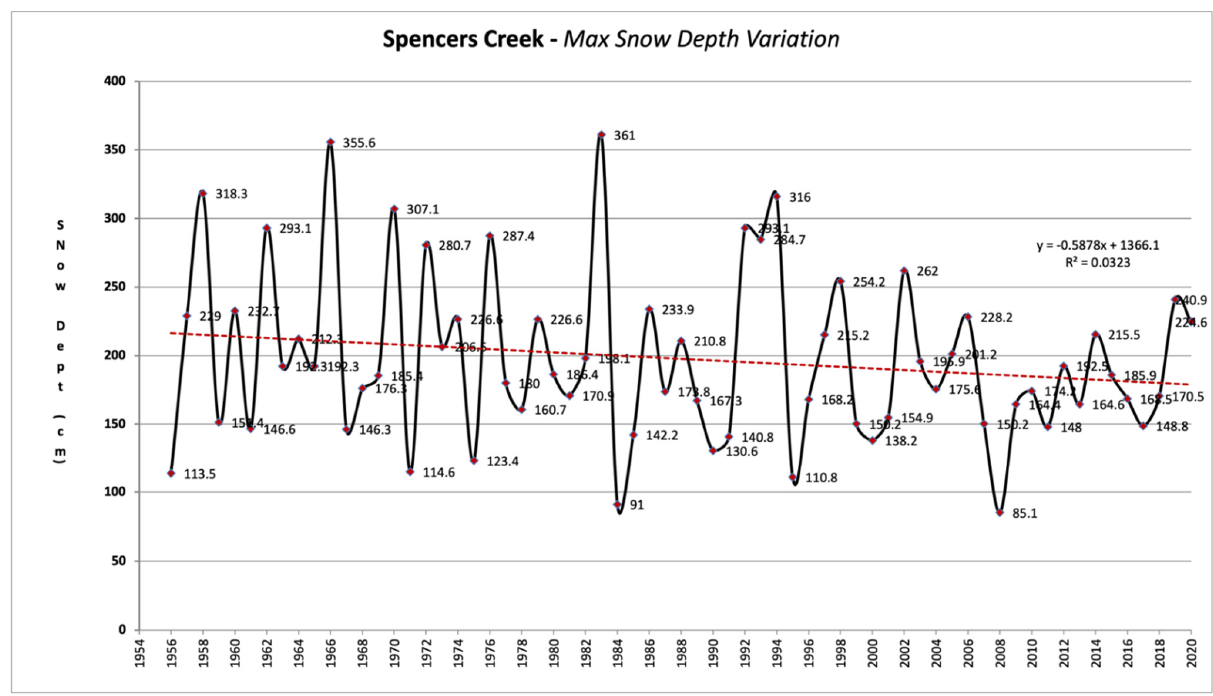
Figure A2. Interannual time series of the observed MSD at the Spencers Creek observation site (solid line). The linear regression line with explained variance is shown.